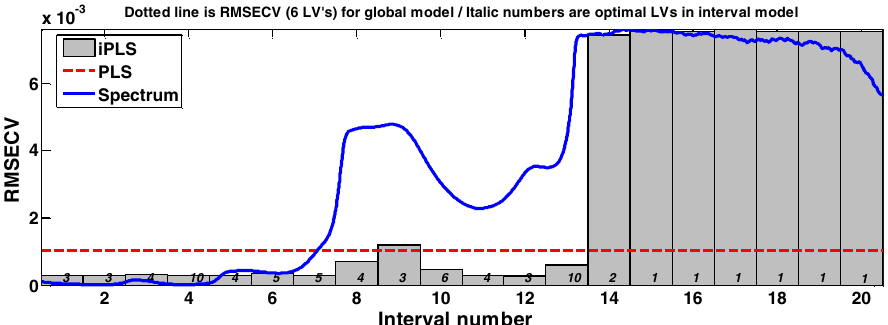
Fig. 4. RMSECV for 20 interval models (bars) and full-spectrum model (black dotted line).